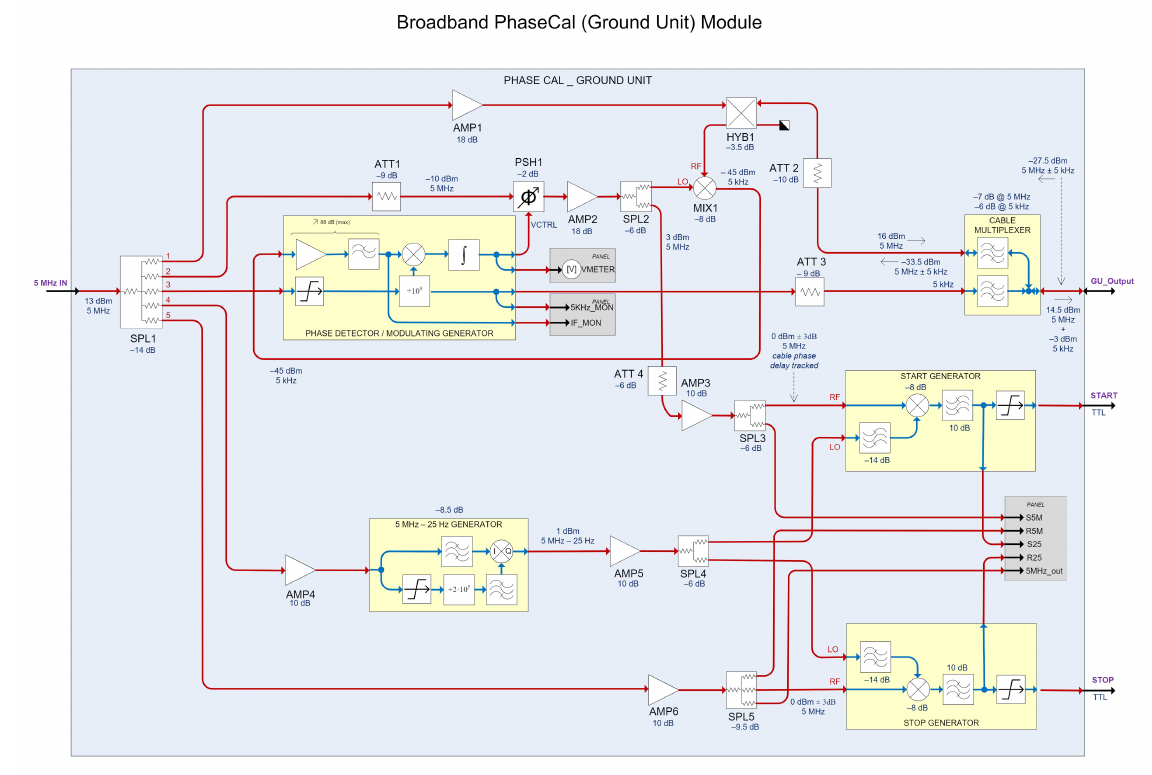
Figure 3. Block diagram of the previous GU designed in Yebes Observatory, and based on the Alan Rogers